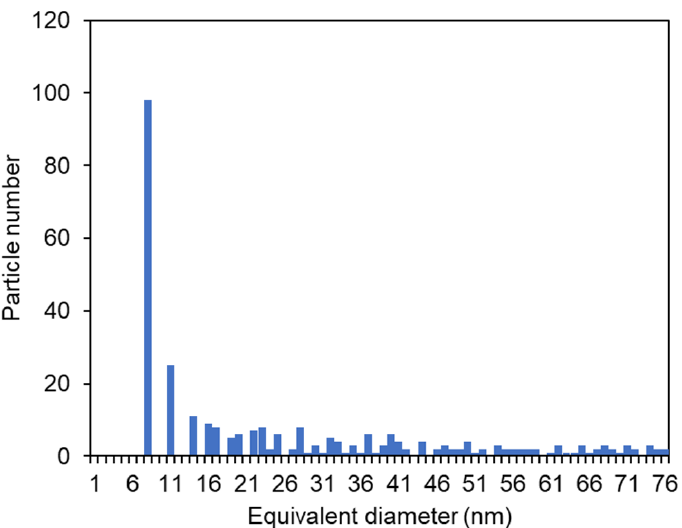
Figure 4. Particle size distribution of the SeNPs prepared with A. macleodii Mo 169 EPS.